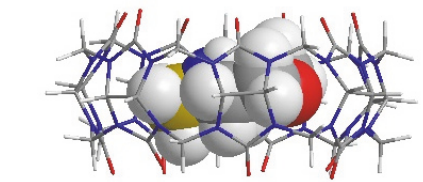
Figure 6: Energy-minimized (MM2, gas-phase) structure of the CB [7] host-guest complex of morpholine